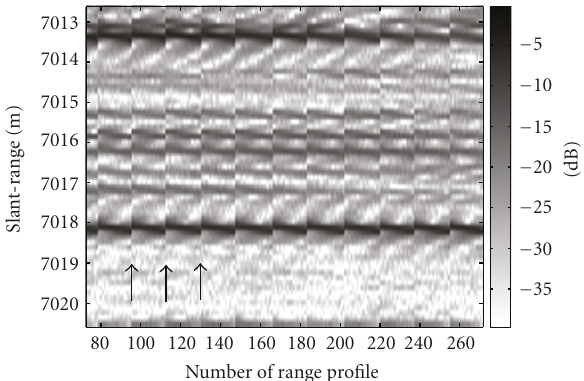
Figure 23: Zoom of Figure 22(a). The jumps in the range profiles are clearly visible.